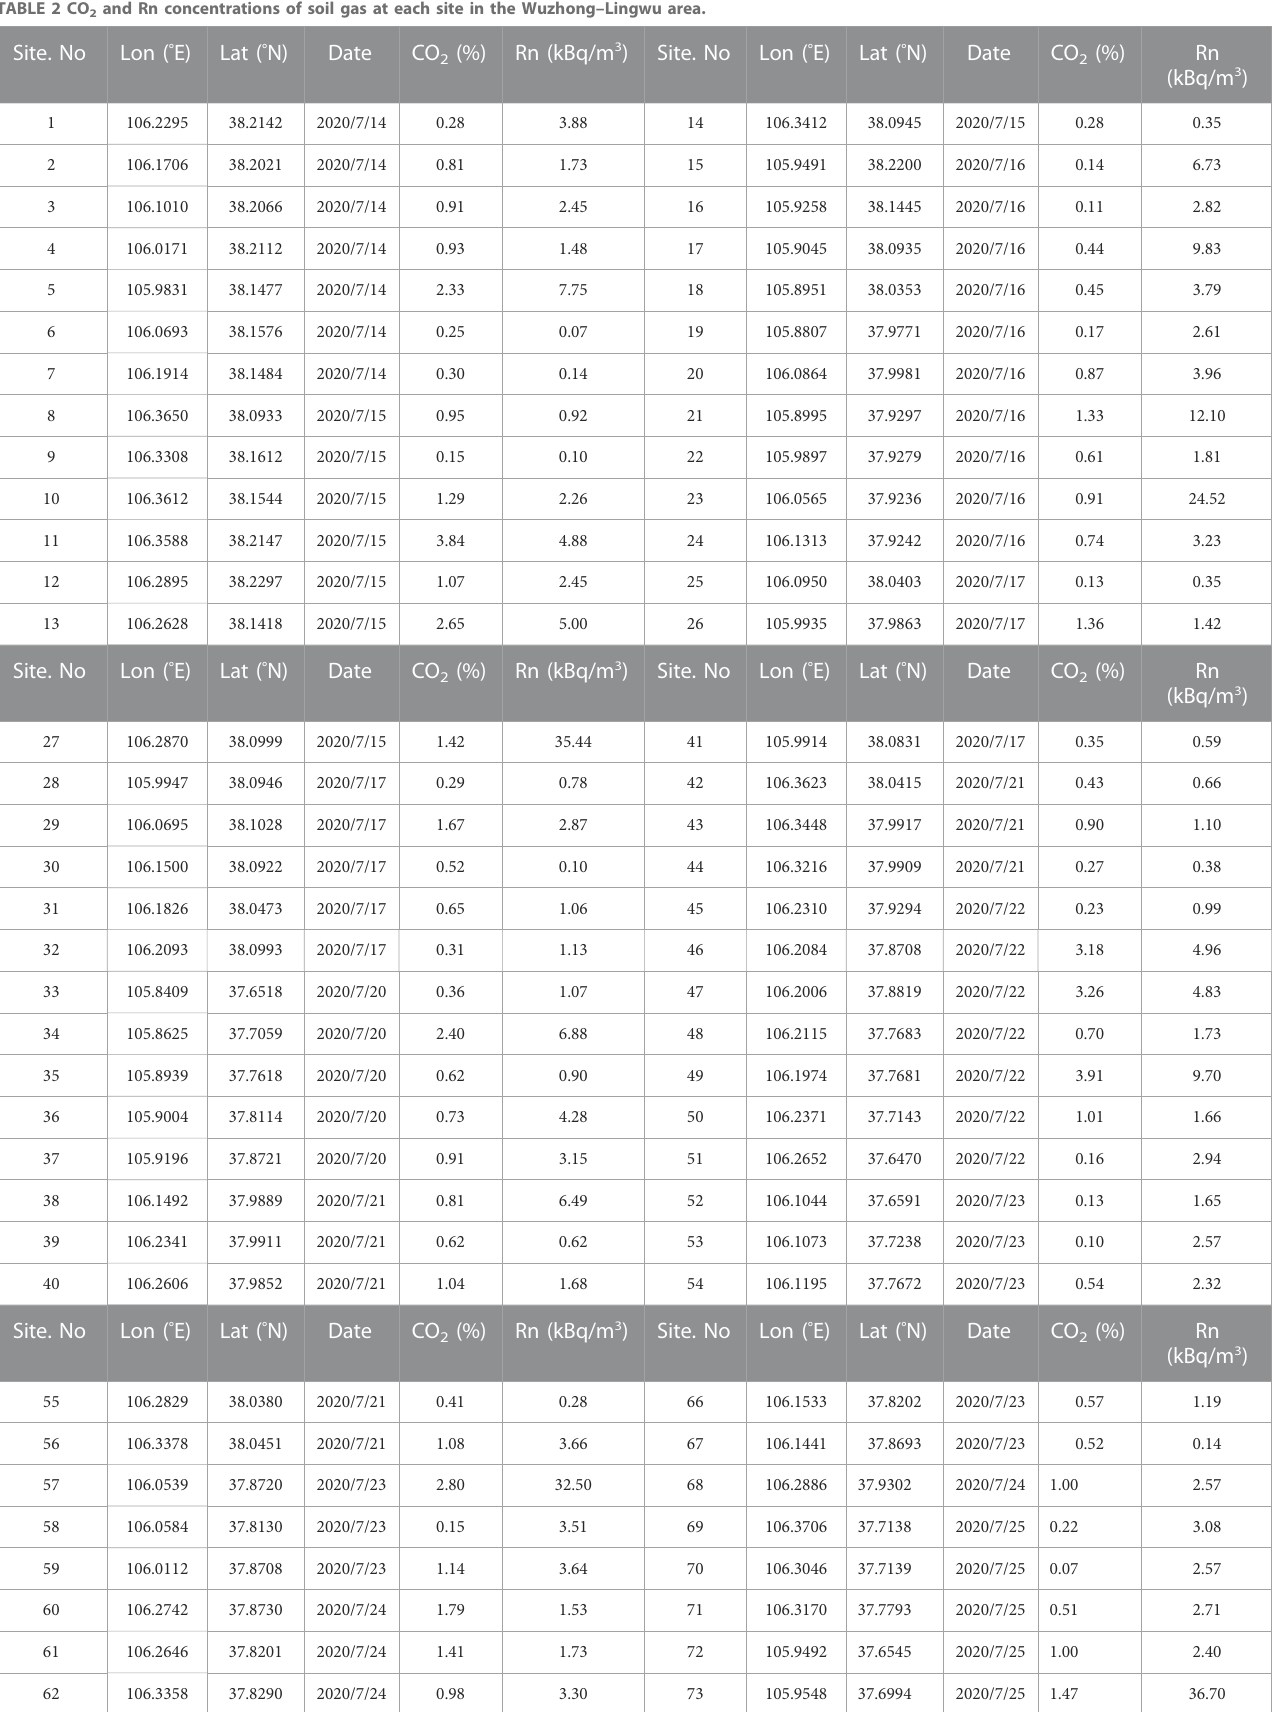
TABLE 2 CO 2 and Rn concentrations of soil gas at each site in the Wuzhong – Lingwu area. Site.